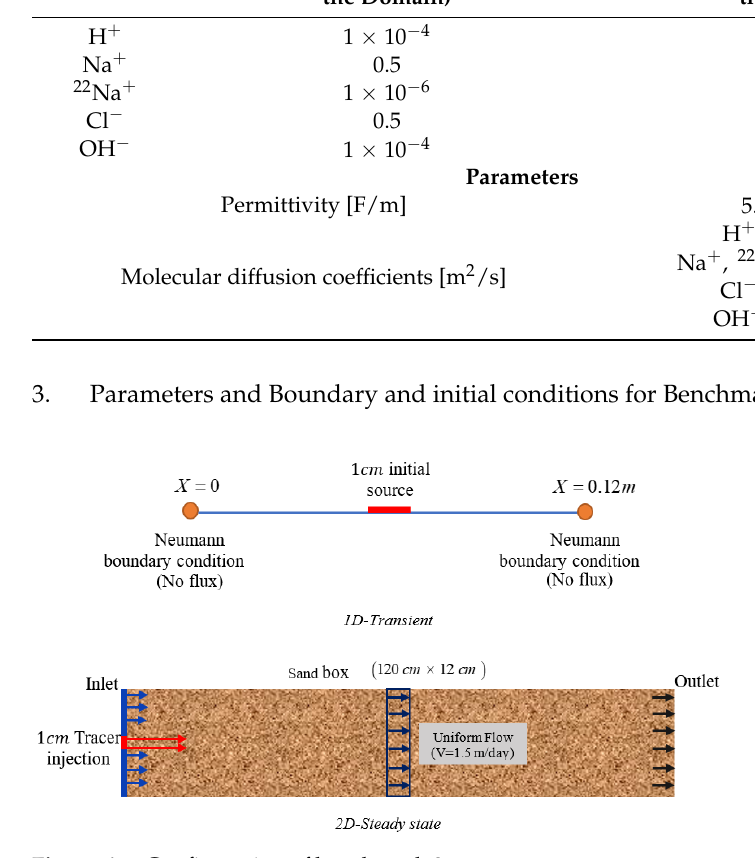
Figure A3. Configuration of benchmark 3.